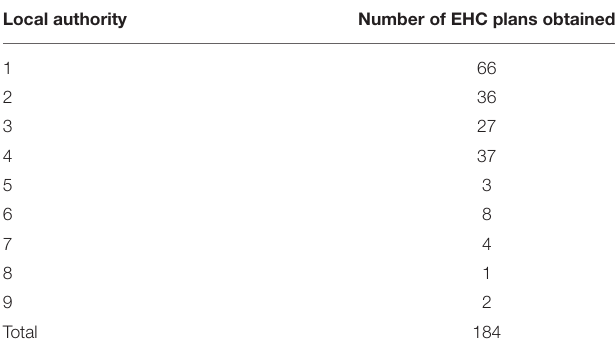
TABLE 1 | Frequency of plans per local